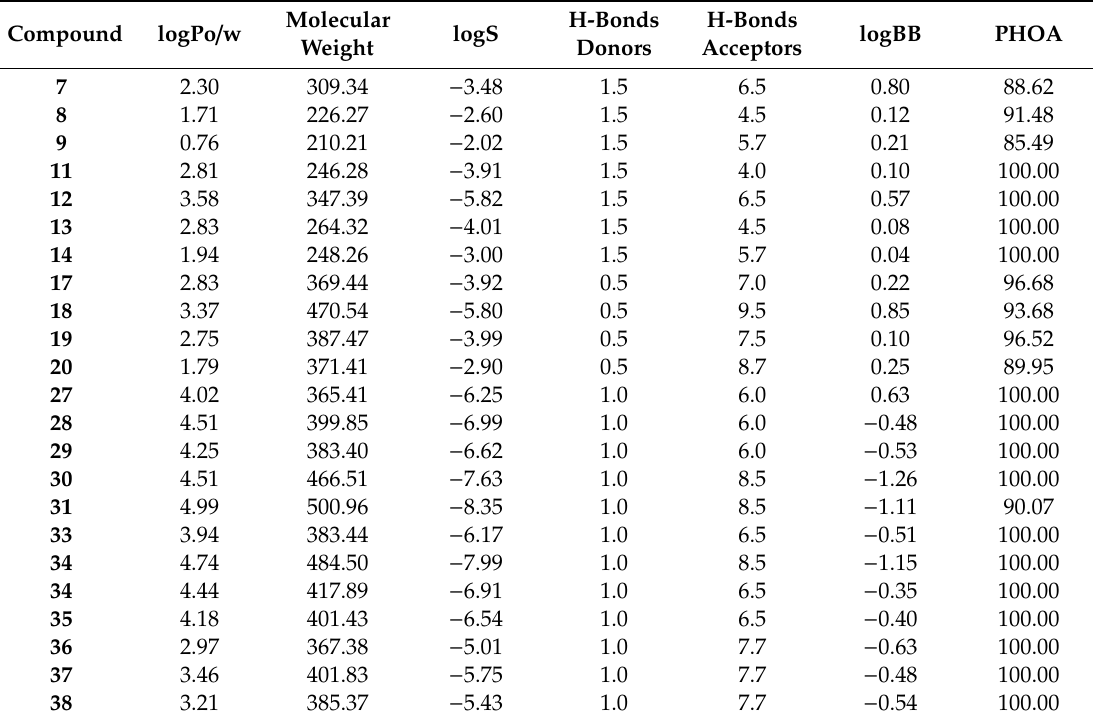
Table 12. Drug likeness score of synthesized